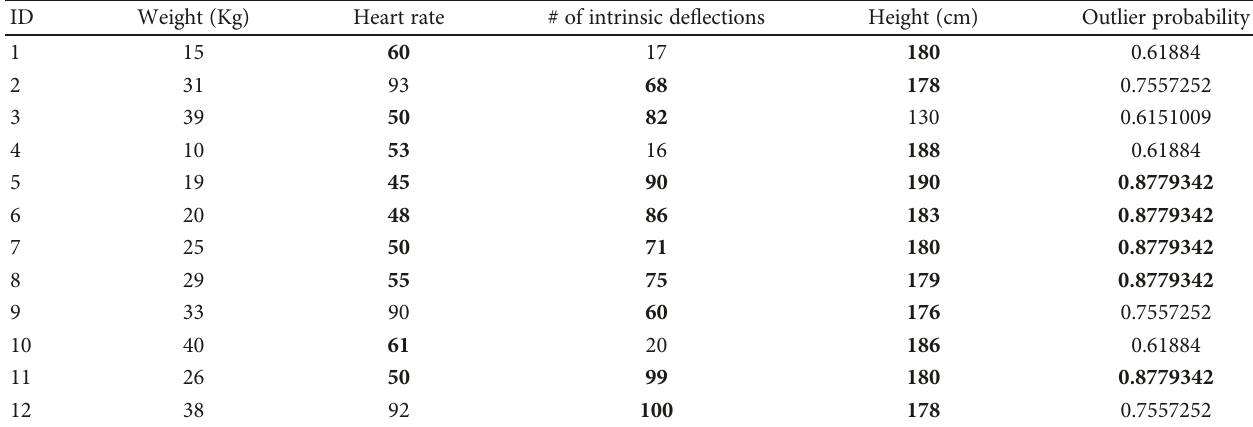
Table 3: Outlier probability of the 12 elements injected into the